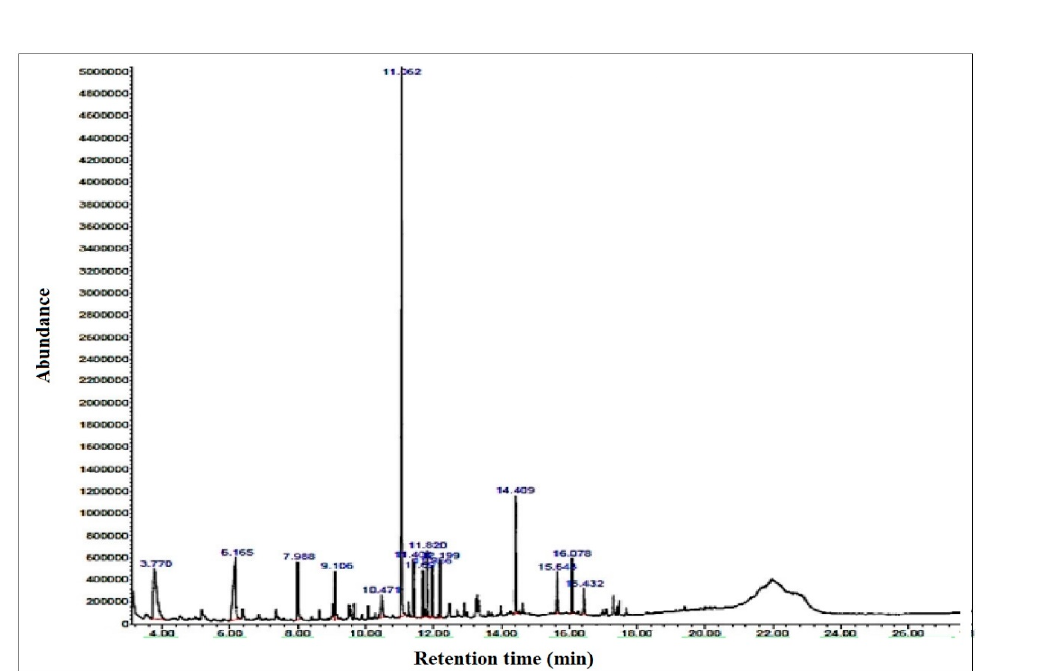
Figure 7. GCMS of oil collected from the pyrolytic decomposition of lignin in the presence of catalyst. Table 3. Composition of bio ‐ oil collected from lignin pyrolysis in the presence of catalyst.